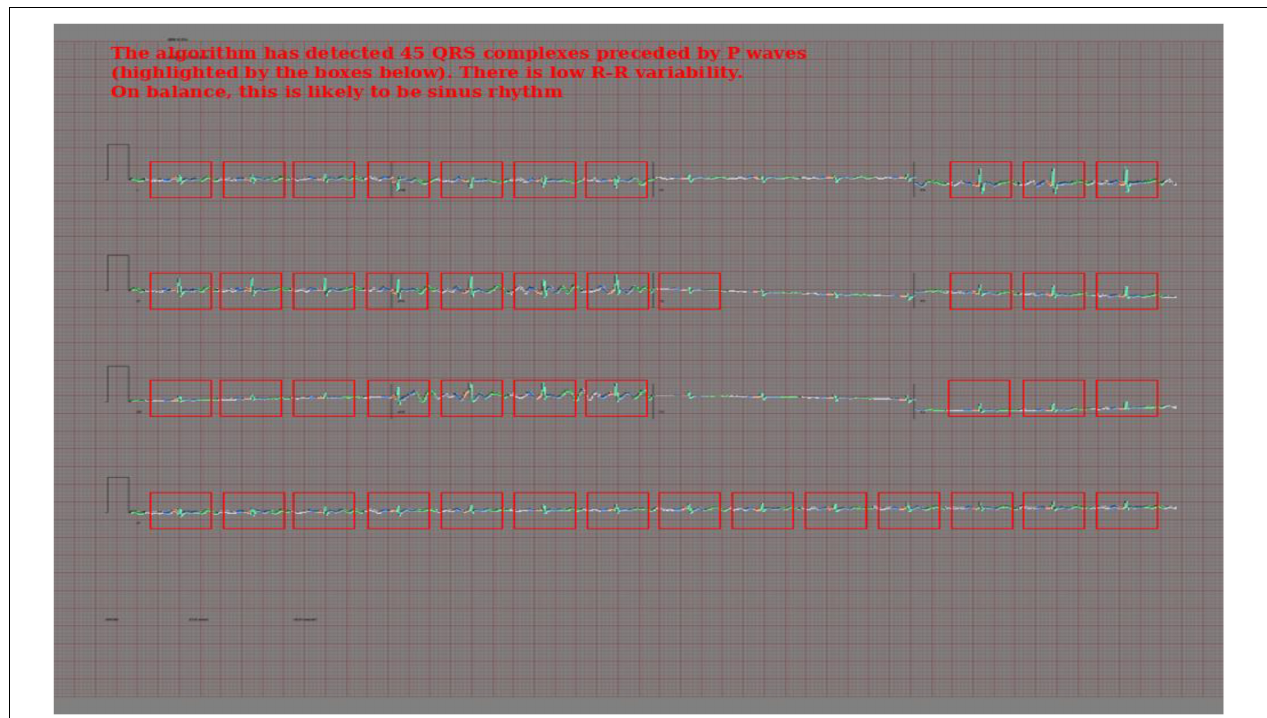
FIGURE 7 | Output of the rule-based AF detection algorithm. The authors propose that this is highly explainable compared with end-to-end AI analysis.